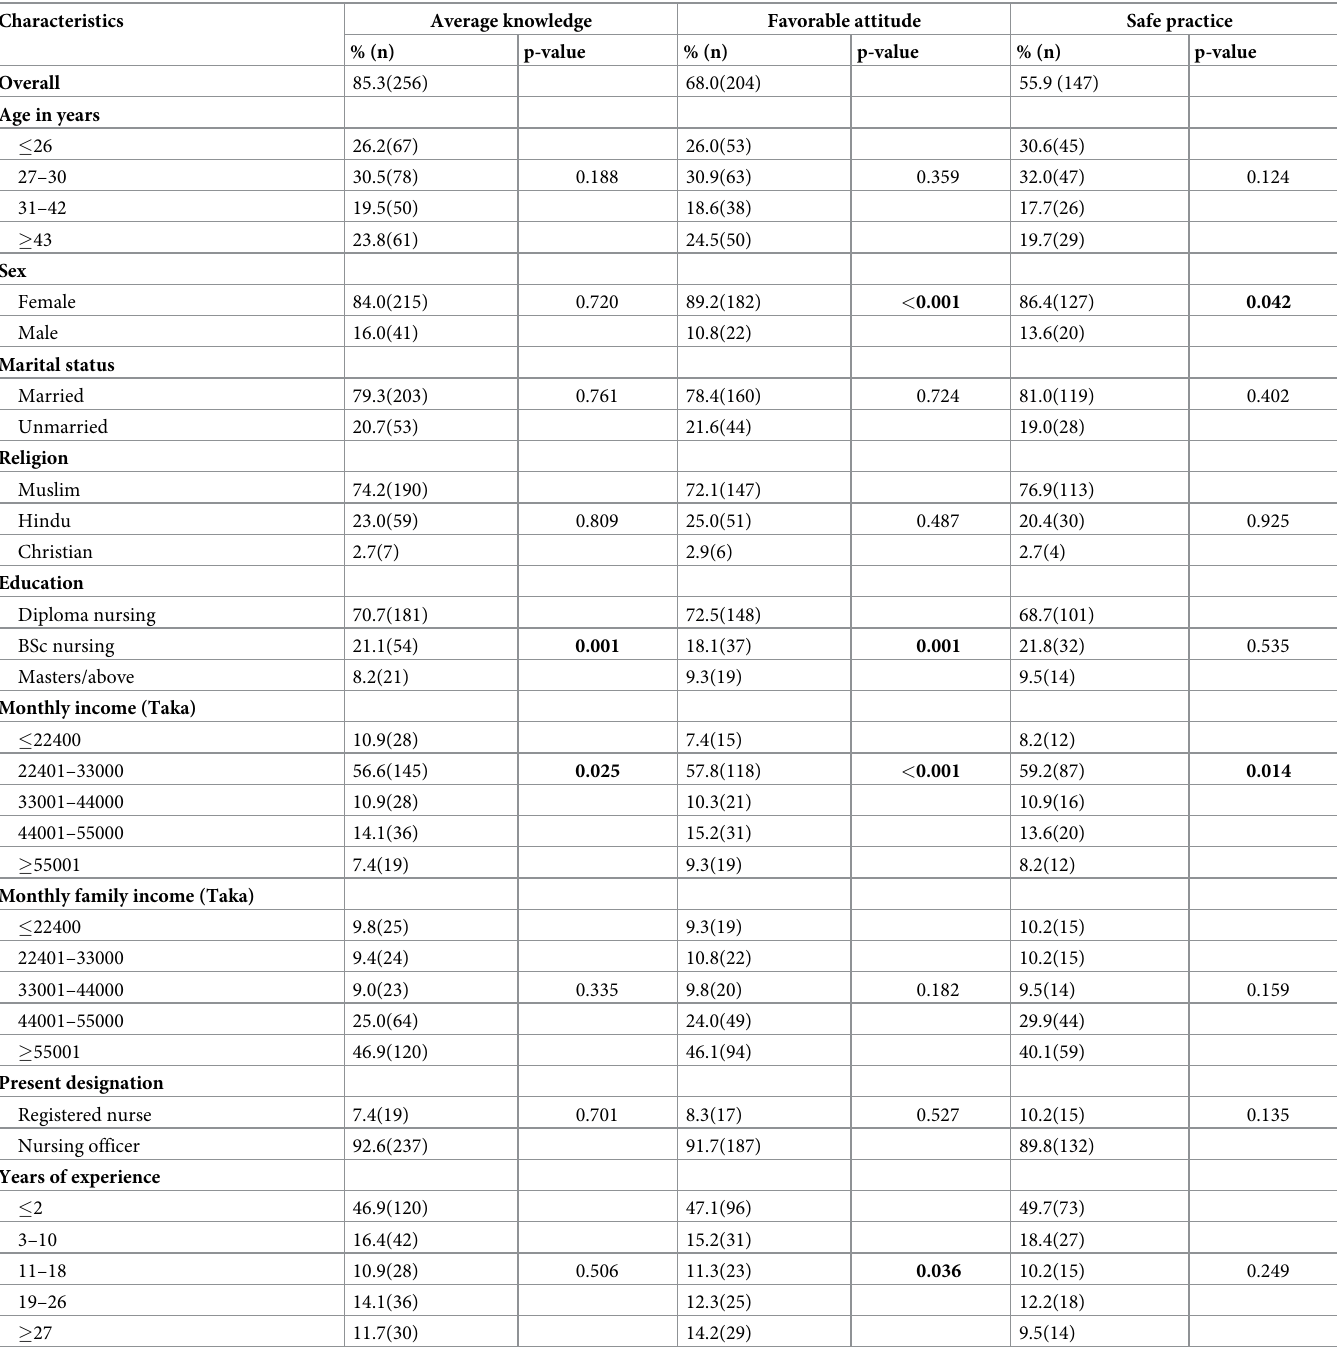
Table 5. Relationship of average knowledge, favourable attitudes and safe practices scores with participant characteristics, 2017–2018, Dhaka Medical College Hos- pital, Bangladesh (N = 300).